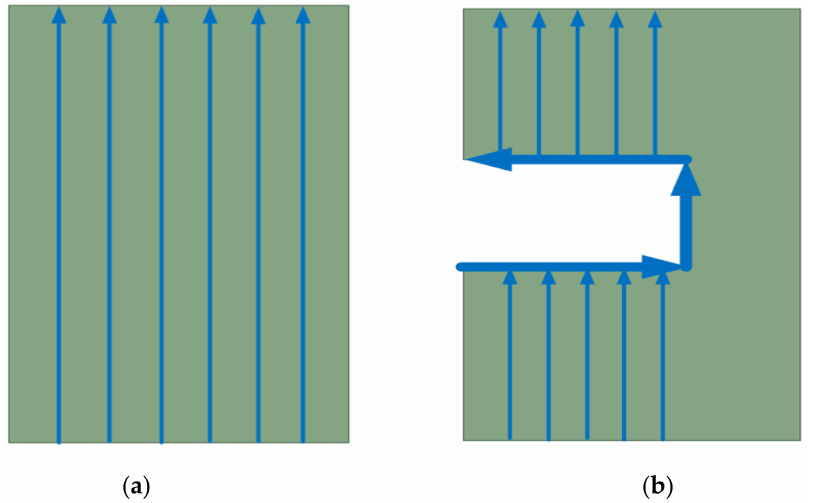
Figure 3. Theoretical current distributions on the metal wall ( a ) without meandering slots and ( b ) with meandering